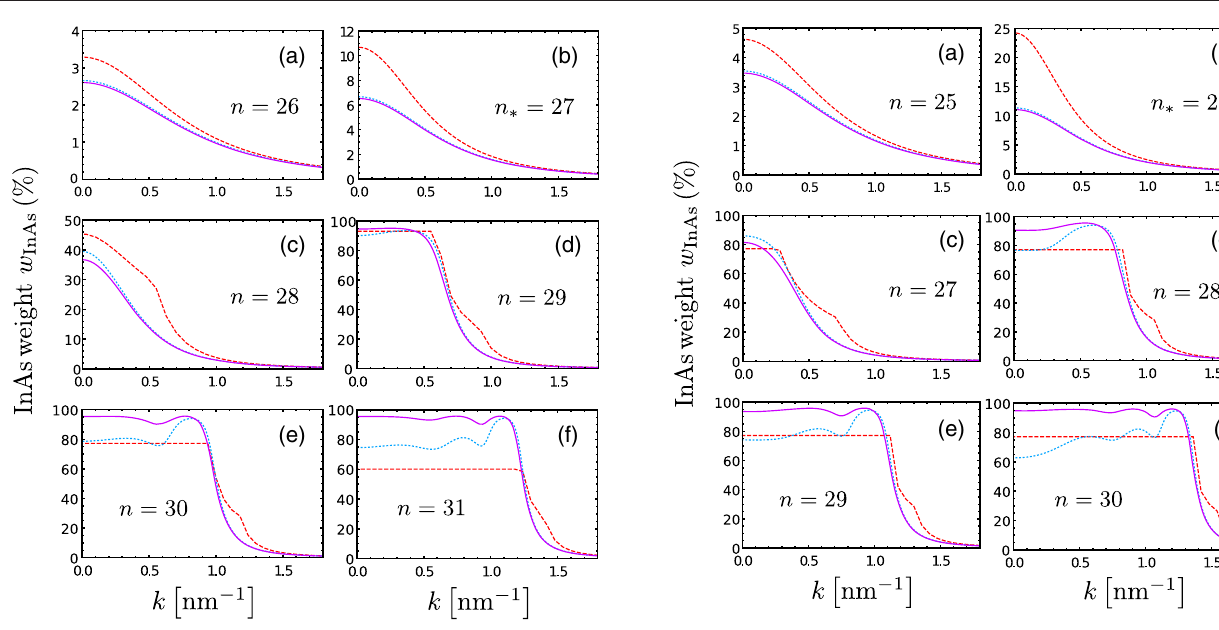
FIG. 6. (a) – (f) InAs weights for L 1 ¼ 4 . 75 nm and Φ ¼ 0 . 1 eV. Solid purple line: Weights obtained numerically using the self-consistent Schrödinger-Poisson method for L 2 ¼ 100 nm. Dotted blue line: Weights obtained numerically using the Schrödinger equation within the square-well model for L 0 2 ¼ 16 nm. Dashed red line: Weights obtained within the square-well model using the approximate analytical expressions of Eqs. (14), (17), and (24) for L 0 2 ¼ 16 nm. The energetically highest weakly modified Al level is the one with n ¼ 26 . The (cid:3) two numerical methods yield quite similar results up to n ¼ 28